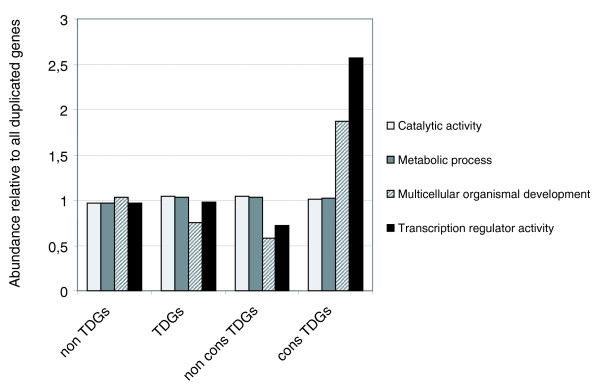
Evolutionarily conserved TDGs are enriched in developmental and transcription factor genes. The graph shows the ratio of the abundance of the listed GO categories in the different subsets of duplicated genes to the abundance among all duplicated genes. A value of 1 indicates that the abundance in a subset is comparable to that in the whole set. The conserved TDG subset is enriched in genes under the categories 'multicellular organismal developmental' and 'transcription factor activity'. p-values for individual children GO terms of these categories found to be overrepresented among conserved TDGs are all < 0.05 (Additional data file 5). Abbreviations: non TDGs, duplicated genes that are not arranged in tandem; TDGs, duplicated genes that are arranged in tandem; non cons TDGs, tandem duplicates that are not conserved in A. gambiae; cons TDGs, tandem duplicates that are conserved between D. melanogaster and A. gambiae.